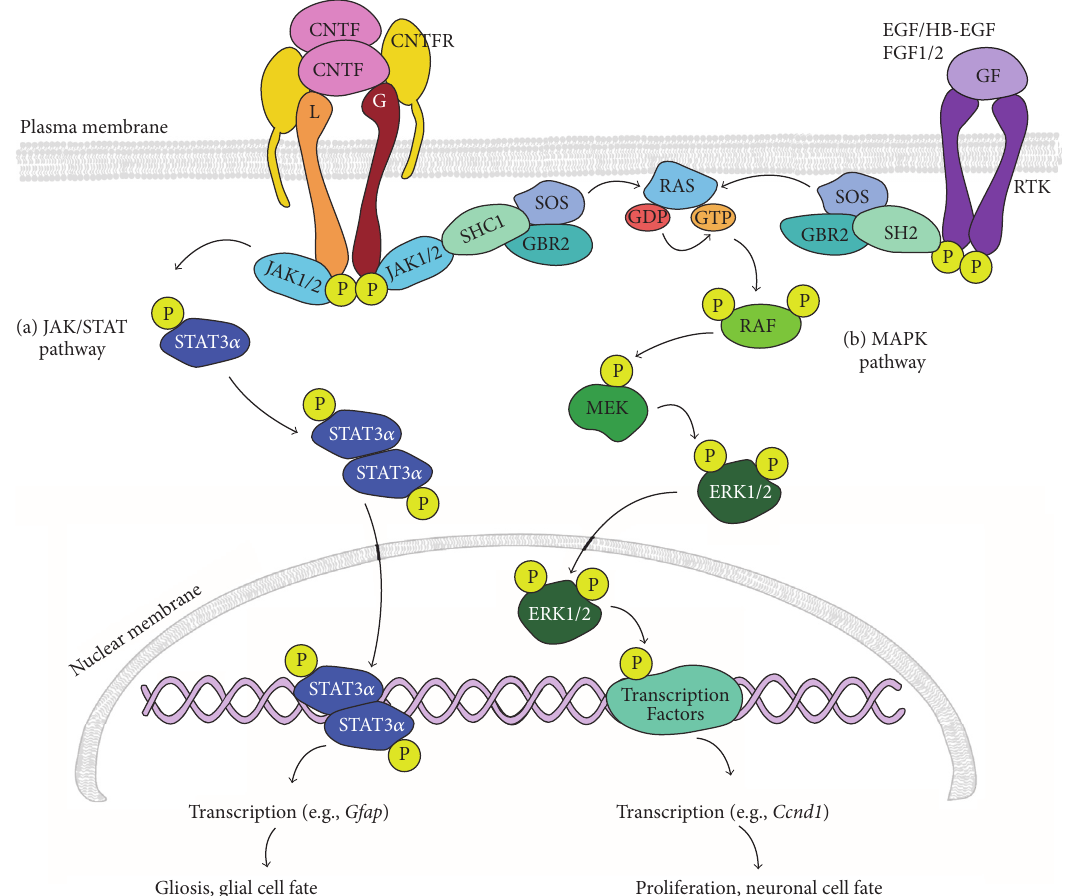
Figure 2: Summary diagram of JAK/STAT and MAPK signal transduction. (a) To activate JAK/STAT signaling, CNTF binding to the GPI linked CNTFR 𝛼 initiates recruitment of LIFR 𝛽 (L) and GP130 (G) to form the hexameric CNTF receptor complex. Recruited LIFR 𝛽 and GP130 are phosphorylated on their cytoplasmic domain by JAK1/2. Activated JAK1/2 phosphorylate STAT3 𝛼 , which forms homodimers that translocate to the nucleus. pSTAT3 homodimers bind to DNA and activate transcription of target genes, such as Gfap , to initiate gliosis. (b) The MAPK signaling pathway can be activated downstream of ligand binding to receptor tyrosine-kinases (RTKs) by growth factors including HB-EGF, EGF, FGF1, and FGF2 or by activation of CNTFR by CNTF. In both pathways, adaptor proteins such as GBR2 recruit SOS to the activated receptor, and subsequent activation of SOS leads to phosphorylation of RAS, MEK, and finally ERK1/2. Activated ERK1/2 translocate into the nucleus and phosphorylate several transcription factors involved in cell proliferation, cell survival, and cell